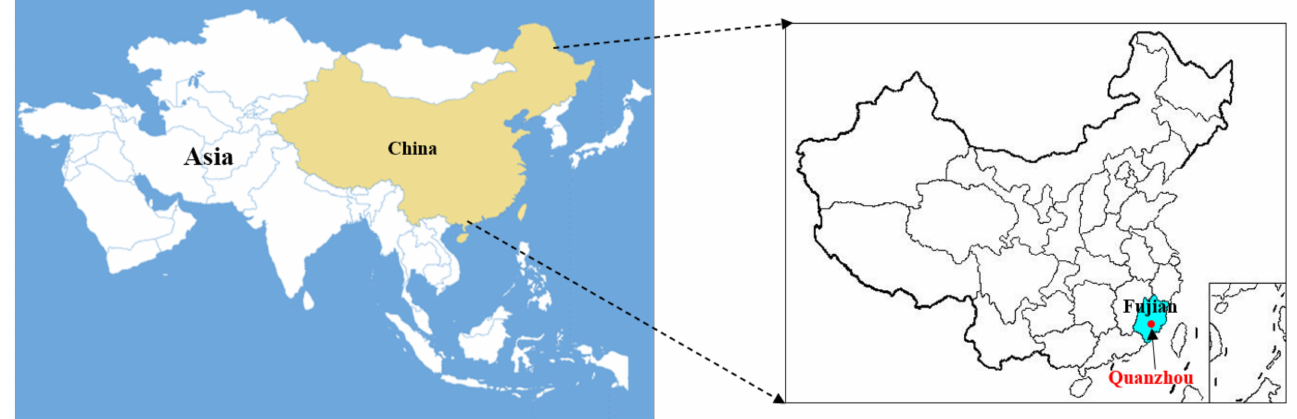
Figure 6. Location of the collapsed